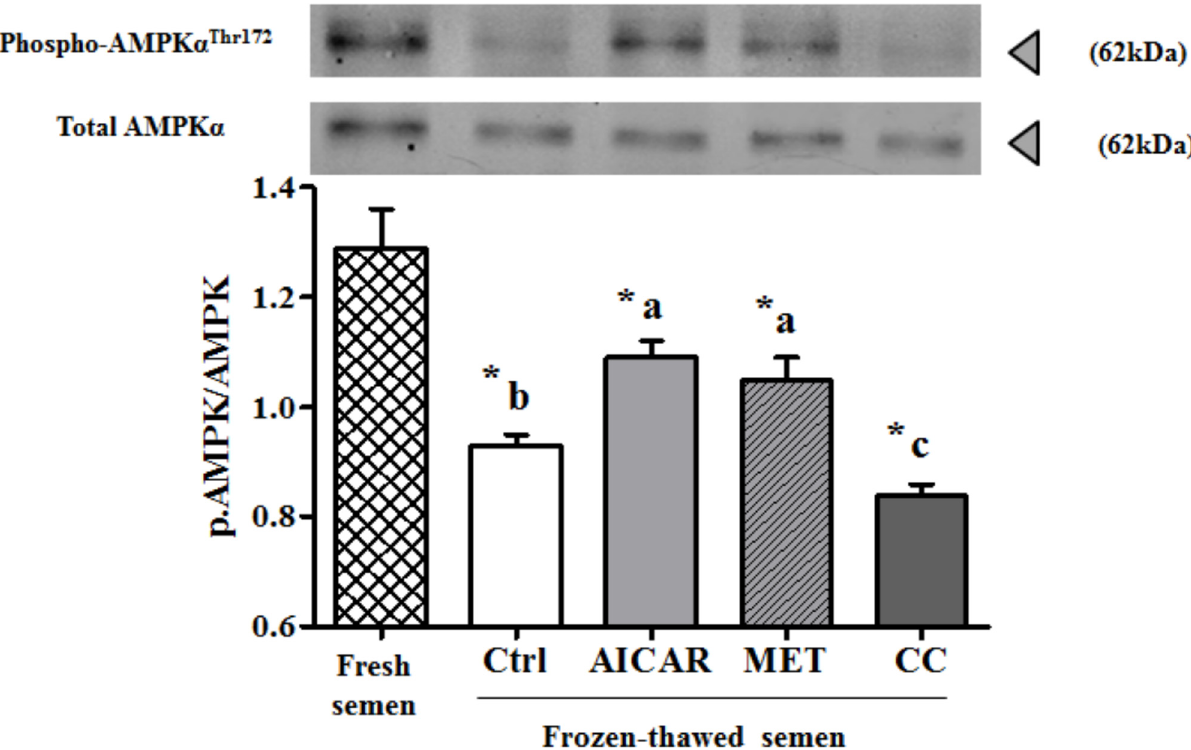
Fig 1. Modulators effects on AMPK phosphorylation in frozen-thawed chicken sperm. Sperm lysates were prepared and resolved by SDS-PAGE, transferred to nitrocellulose membrane, and probed with anti-phospho-Thr172-AMPK α and anti-AMPK α antibody. Bands for phospho-Thr 172 -AMPK α were detected at 62kDa (top lanes). Total AMPK α was used as loading control (62kDa) (bottom lanes) and the phosphorylated protein AMPK α (Thr172)/ total AMPK α ratio is shown at the bottom. Cryopreserved sperm were treated in the presence of an AMPK activator (2mM AICAR (in light gray) or 1mM MET (in diagonals)) or an AMPK inhibitor (5 μ M CC (in dark gray)) or Control (Ctrl, in white); Fresh semen (checkered pattern). Values represent means ± SEM from 6 different experiments (4 samples/experiment). Different superscripts indicate significant differences between Ctrl and treatments (AICAR, MET or CC) in frozen-thawed semen ( a,b,c , P < 0.05). Asterisks indicate statistically significant differences between fresh and frozen-thawed semen ( * , P < 0.05).